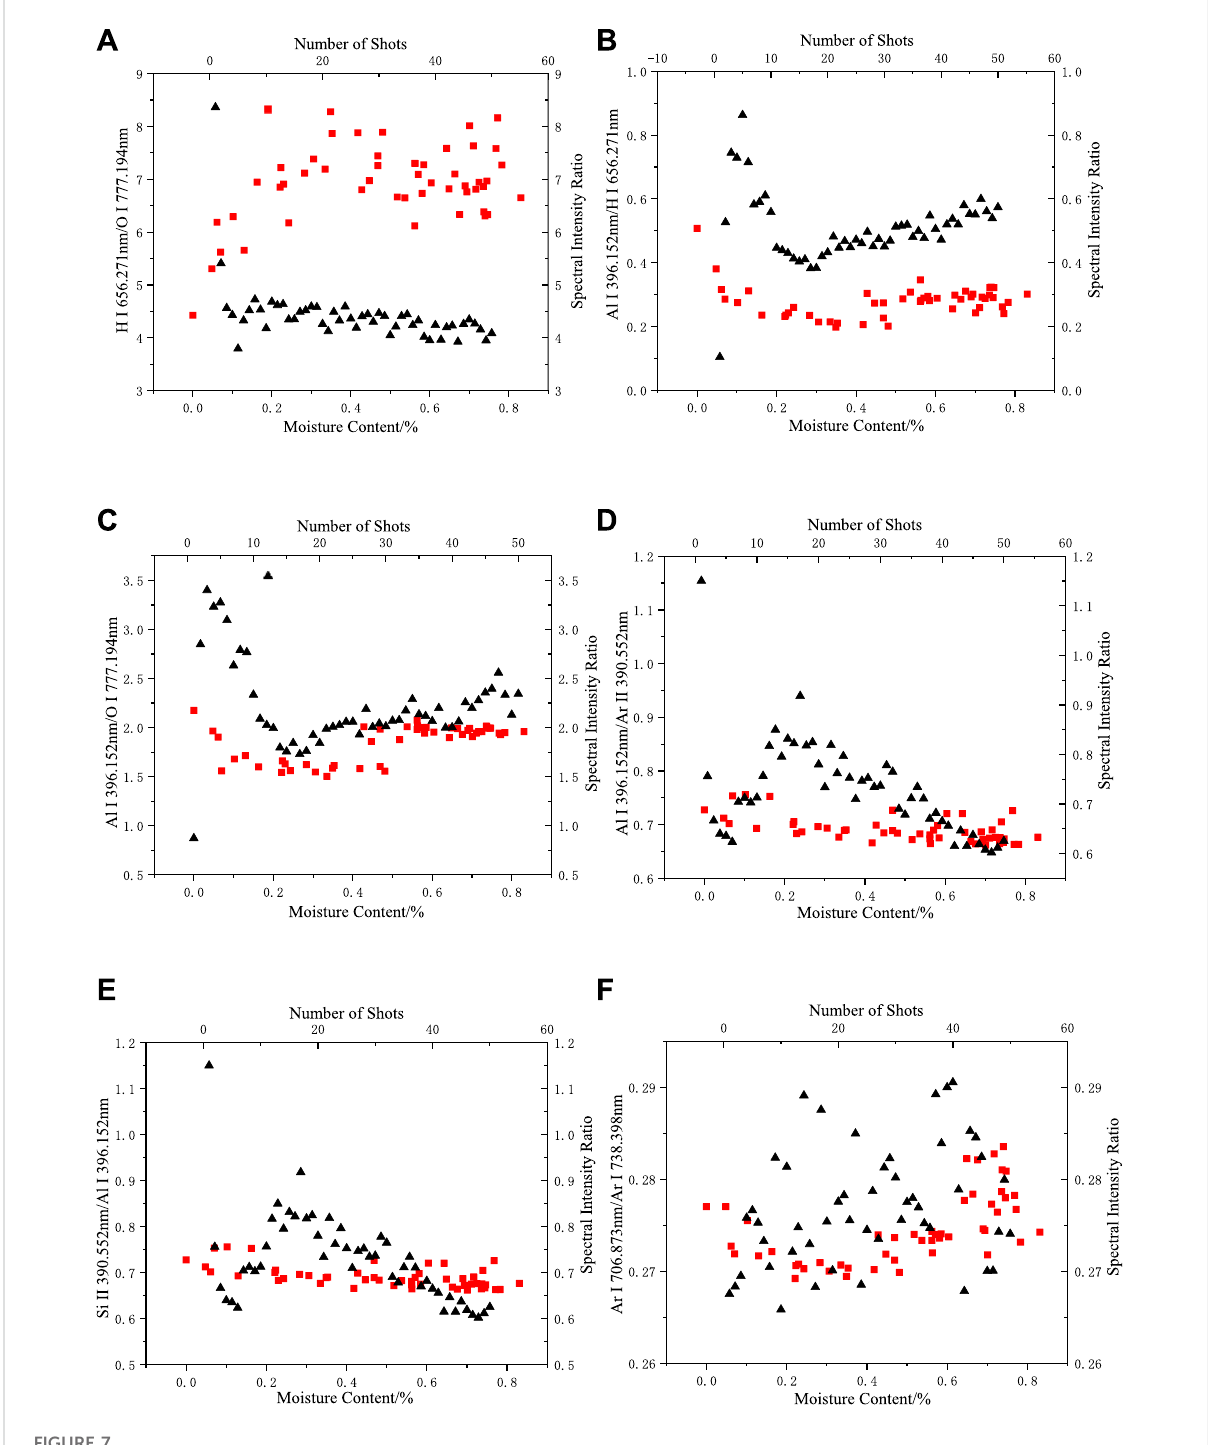
FIGURE 7 Changes in spectral intensity ratio with moisture content and number of shots in an argon environment: (A) H I 656.271 nm/O I 777.194 nm, (B) Al I 396.152 nm/H I 656.271 nm, (C) Al I 396.152 nm/O I 777.194 nm, (D) Al I 396.152 nm/Ar II 390.552 nm, (E) Si II 390.552 nm/Al I 396.152 nm (F) Ar I 706.873nm/ArI738.398 nm(the “ square ” representsthechangeofspectralintensityratiowithmoisturecontent, “ triangle ” representsthechangein the spectral intensity ratio of dried silicone rubber with the number of